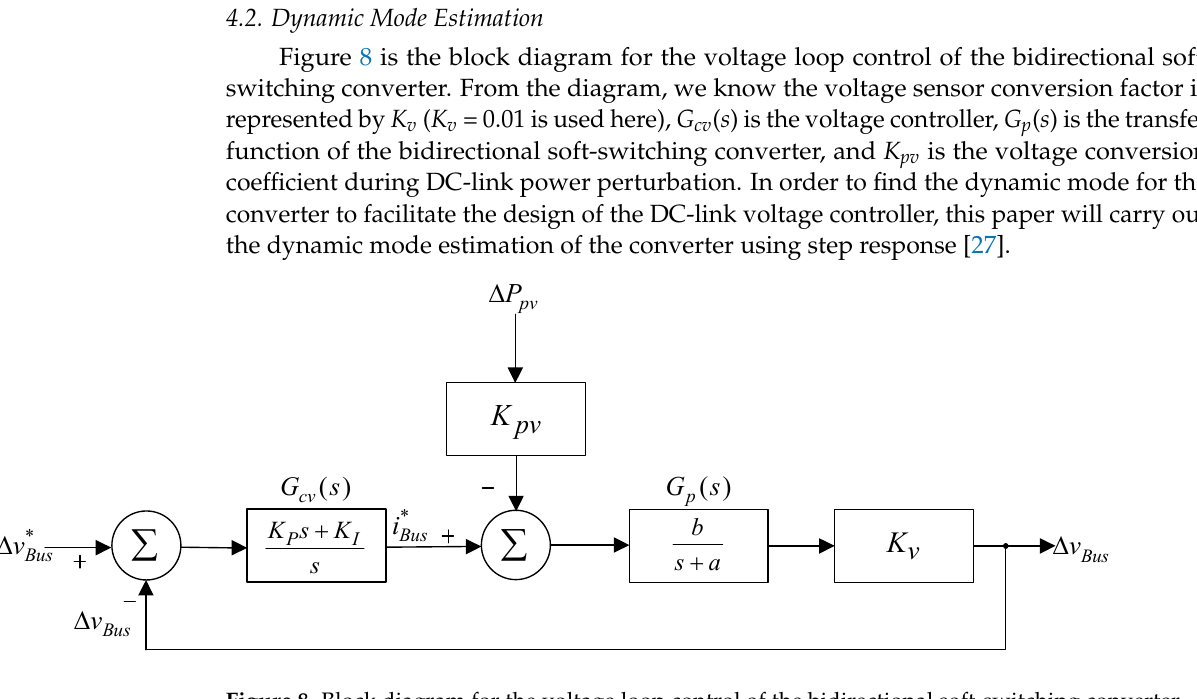
K ,  under different K Pi . Ii